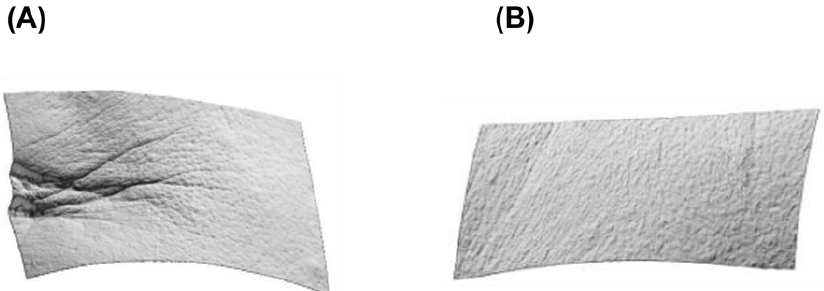
Figure 1. Measurement of wrinkle. Skin roughness was measured using the three-dimensional (3D) skin imaging system, Primos CR (Canfield, OH, USA); the measurements were taken at the areas of the eye ( A ) and glabella ( B ). The Ra (Roughness average) and Rmax (maximum peak-to-valley roughness height) values of the stored images were evaluated.